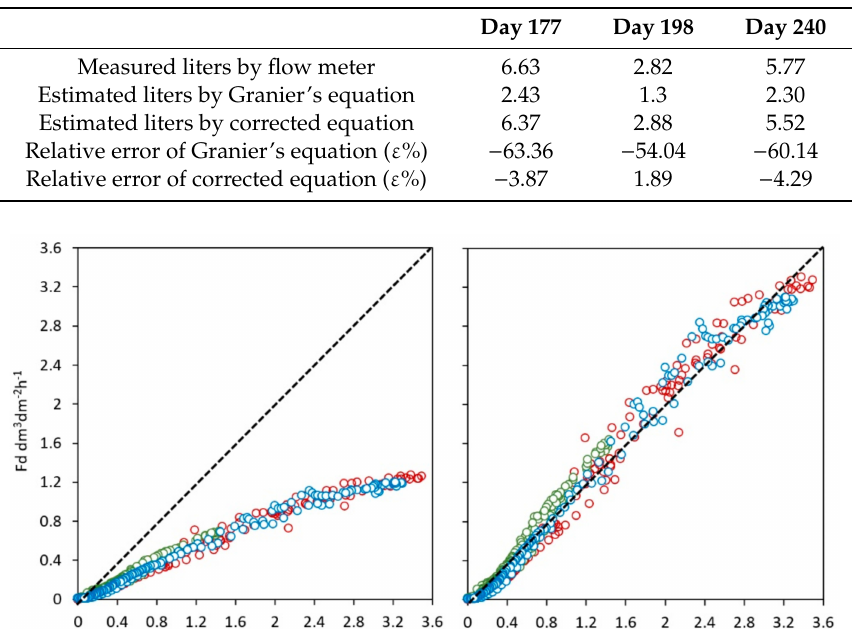
Table 3. Daily sap flow and relative errors of corrected original equation.